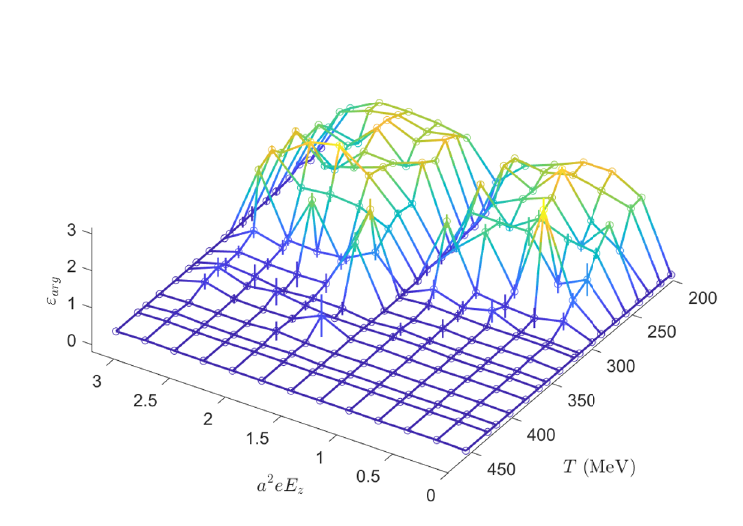
Figure 20 . ε arg as a function of T and E z